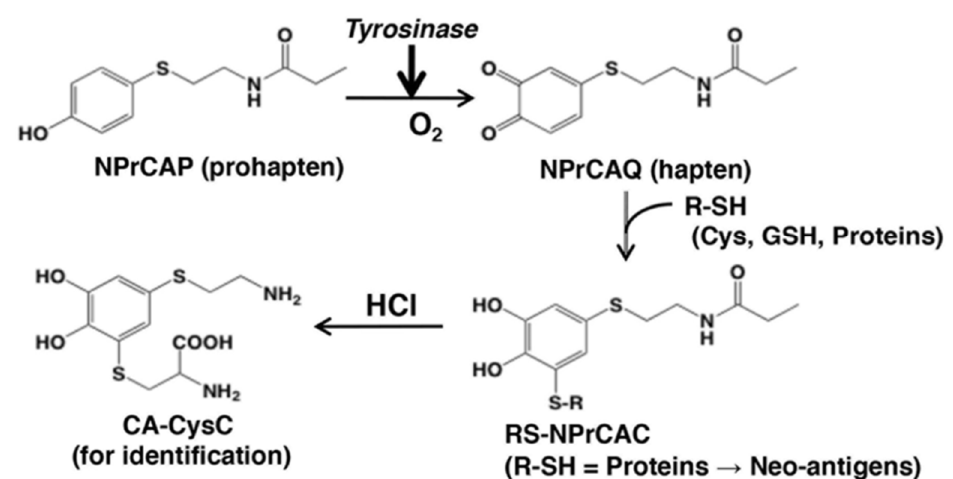
Figure 15. Tyrosinase activation of NPrCAP (prohapten) and binding of the quinone-hapten NPrCAQ to proteins through cysteine residues [28]. Oxidation of NPrCAP with tyrosinase produces the quinone NPrCAQ, which binds to thiols (cysteine, reduced glutathione, melanosomal proteins). The production of NPrCAQ-thiol adducts can be confirmed by the detection of CA-CysC after acid hydrolysis.